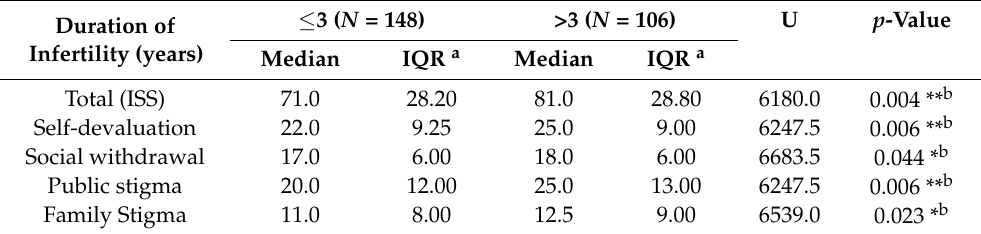
Table 6. Comparison between the ISS scores and duration of infertility ( N = 254).